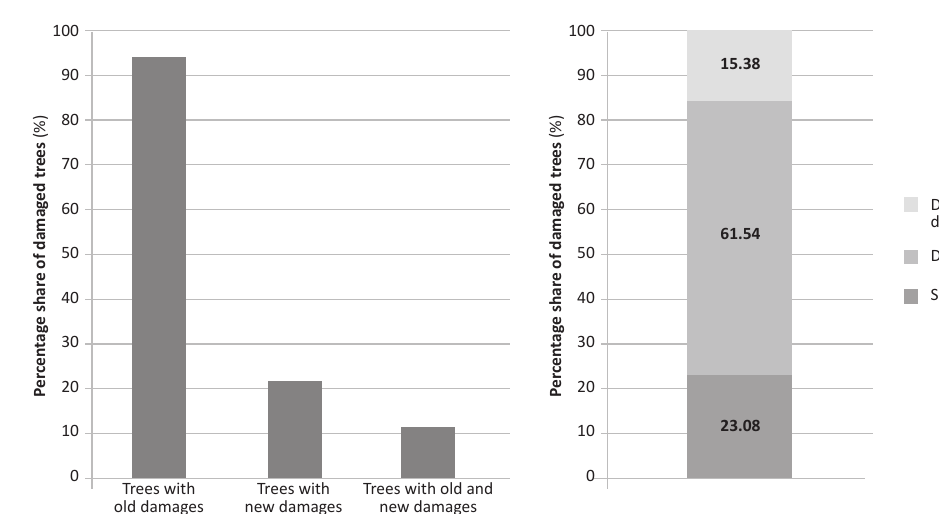
FIgURe 3. The distribution of damaged trees depending on the moment of damage occurrence.